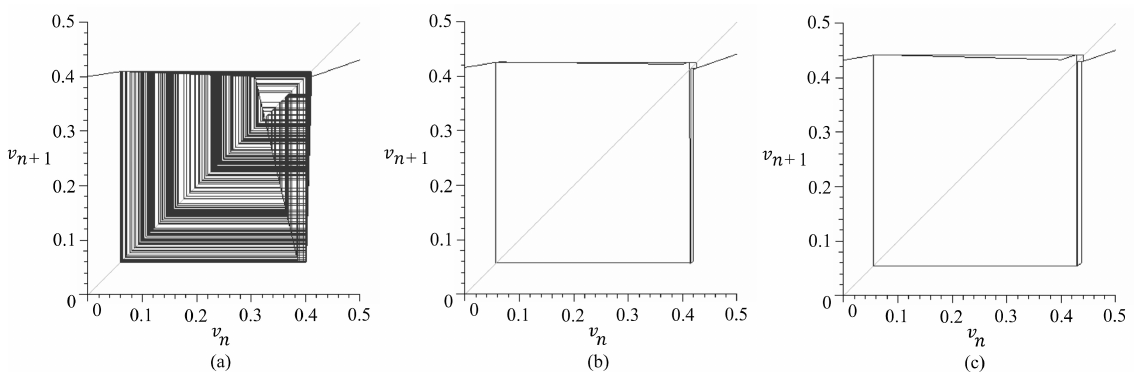
Figure 17. Iterative paths with the initial point: v 0 = 0.5. ( a ) ζ = 0.1. ( b ) ζ = 0.2. ( c ) ζ = 0.3.